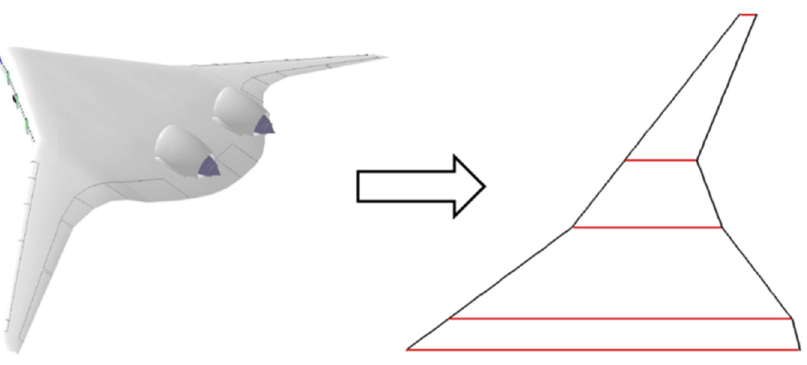
Figure 29. AVECA BWB configuration—data used by the aerodynamic module (5 wing sections).